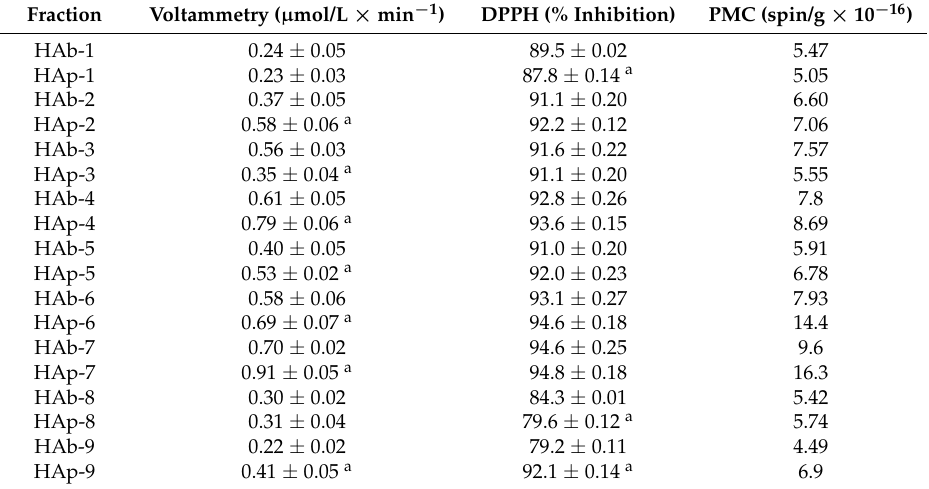
Table 4. Analysis of antioxidant activities of the HA fractions using voltammetry and DPPH assays and determination of the number of paramagnetic centers (PMC) in each